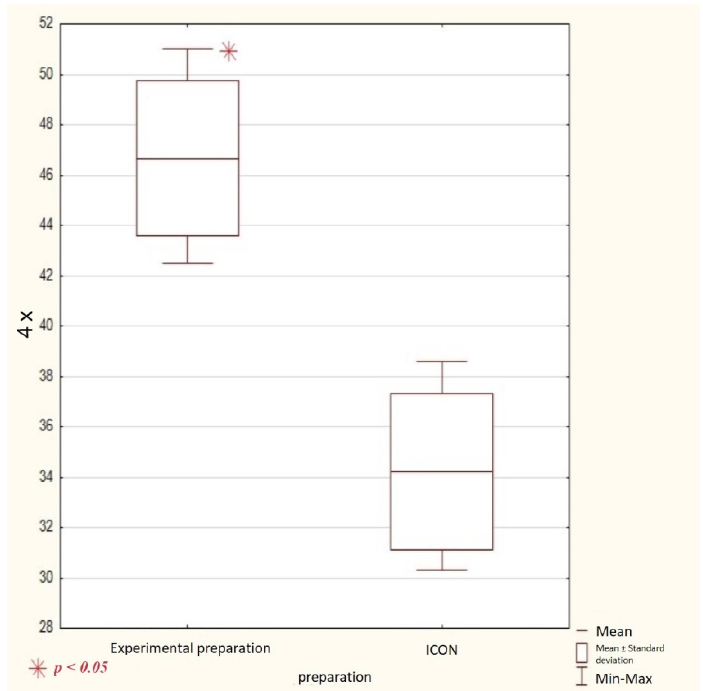
Figure 1. Comparison of mean viability of L-929 cells (%) after 24 h of incubation with a 4-fold dilution of the extract of the experimental preparation and the Icon preparation ( p < 0.05). * statisti- cal significance.